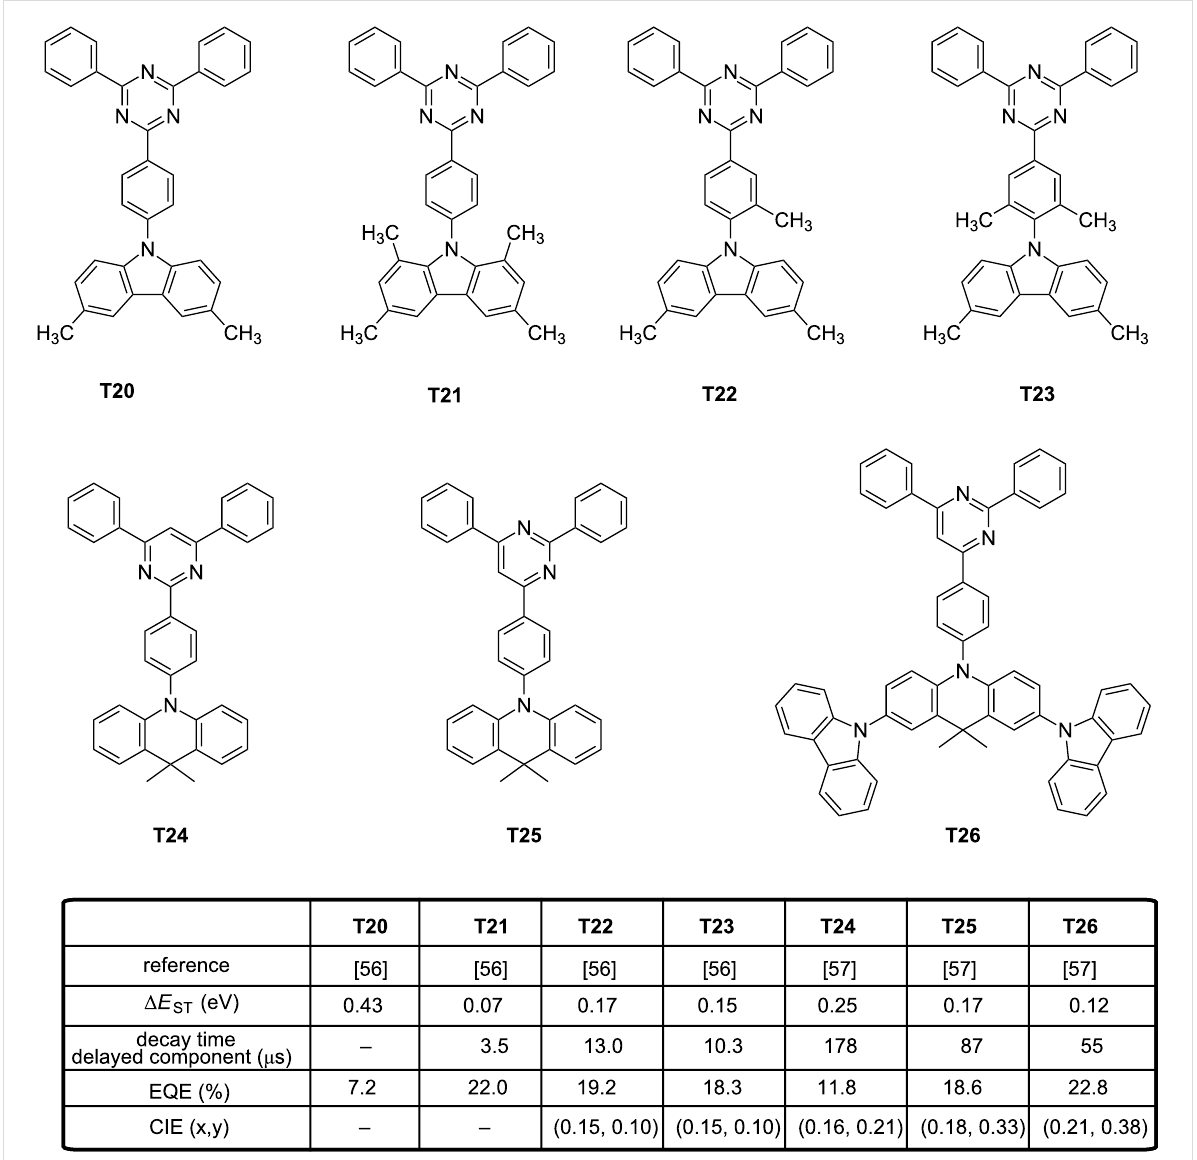
Figure 7: Triazine- and pyrimidine-based TADF emitters T20 – T26 .